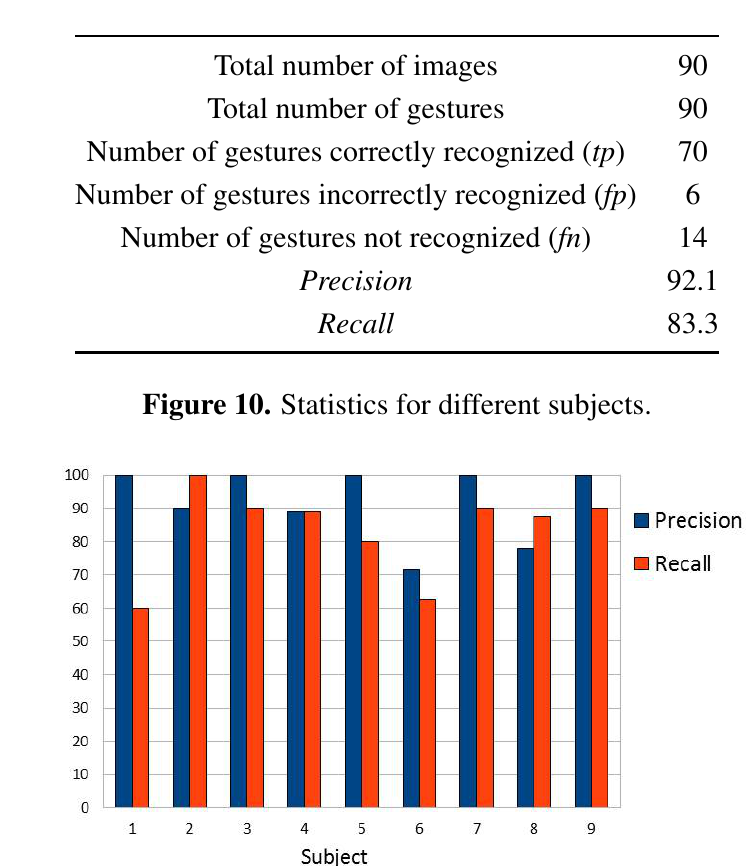
Table 3. Results of the gesture recognition experiments.